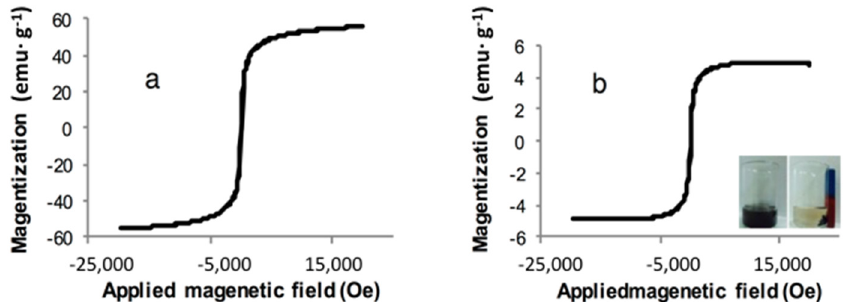
Figure 4. Magnetization hysteresis loops of Fe 3 O 4 ( a ) and MIIP ( b ).